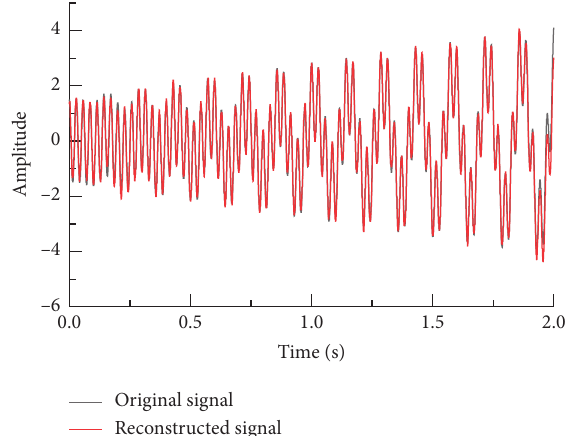
Figure 5: The reconstructed signal and original